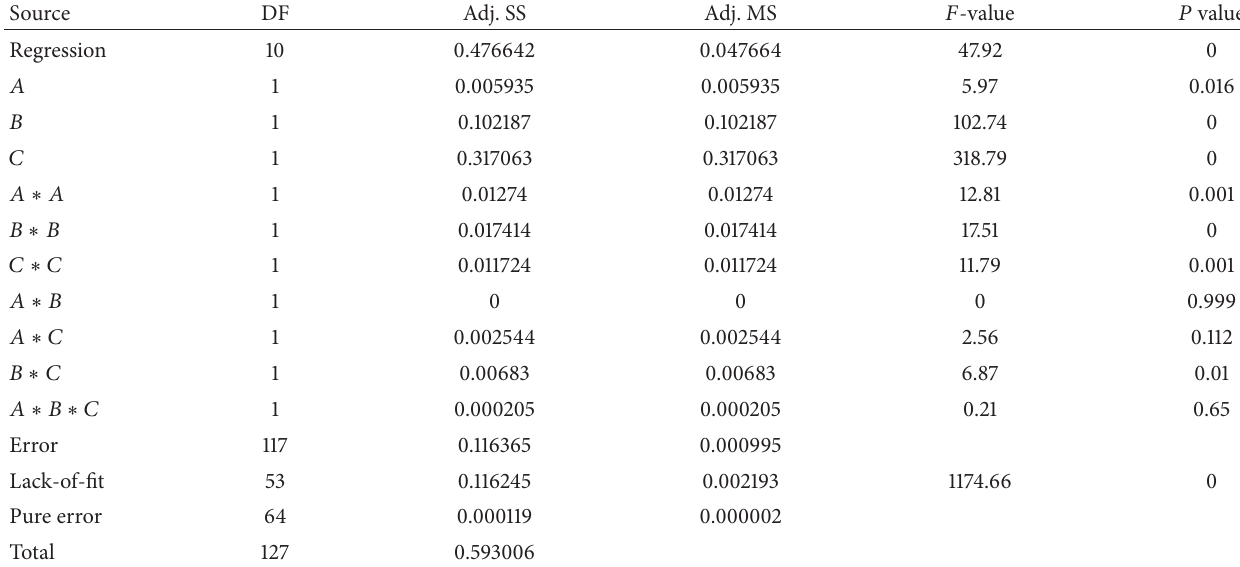
Table 3: ANOVA for 𝑅 𝑎 .